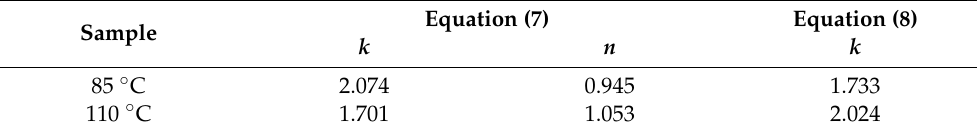
Table 3. Parameters in the strain models for the normal component of the strain matrix. Sample